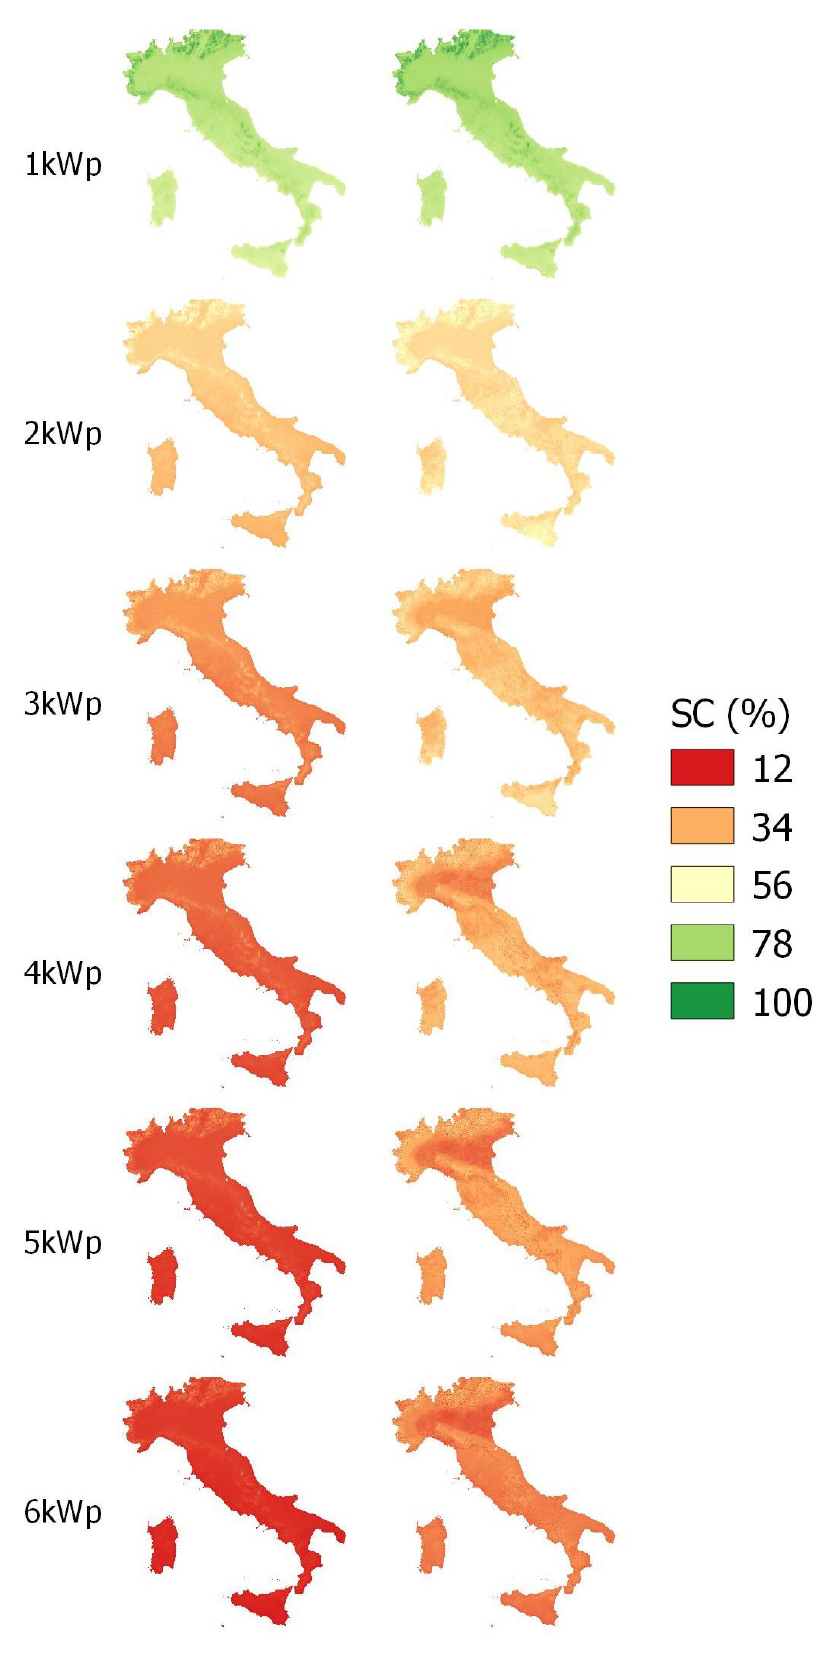
Figure A7. SC for E L = 2700 kWh, left side without battery and right side with